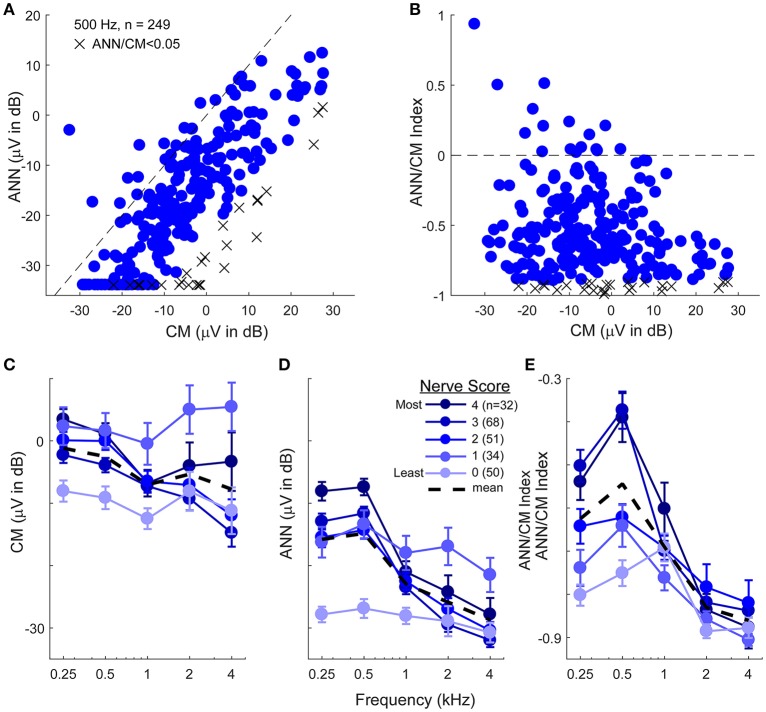
The CM and ANN in human CI subjects. (A) In 249 subjects with significant responses (see section Methods) to 500 Hz tone bursts at 90 dB HL the ANN amplitude was generally smaller than the CM (below the line of equality, dashed) but the two were positively correlated (r = 0.75, p < 0.001). Symbols with an X had an ANN/CM ratio <0.05. (B) The ANN/CM index of the same subjects. On this scale an index of−1 is all CM, 0 is equal amount of CM and ANN, and 1 is all ANN. Usually the CM was greater than the ANN, although in a number of cases they were nearly equal, and in a few the ANN was larger than the CM (C–E). The CM (C), ANN (D), and ANN/CM index (D) as a function of frequency and with the parameter of “nerve score,” which is a subjective scaling of the neural activity in each cases based on visual observation of the CM and ANN. There was no trend for the subjective nerve activity to reflect the size of the CM, in contrast, the size of the ANN and the ANN/CM index reflected the nerve activity. Both also showed low-pass filtering of similar to that in gerbil. The responses included for each frequency had to be significant (see section Methods) so the numbers of cases differ by a small amount for 250–1,000 Hz (>80% of cases have significant responses to these frequencies) but are fewer to 2 and 4 kHz (43 and 26%, respectively). Errors bars in (C–E) are standard error.